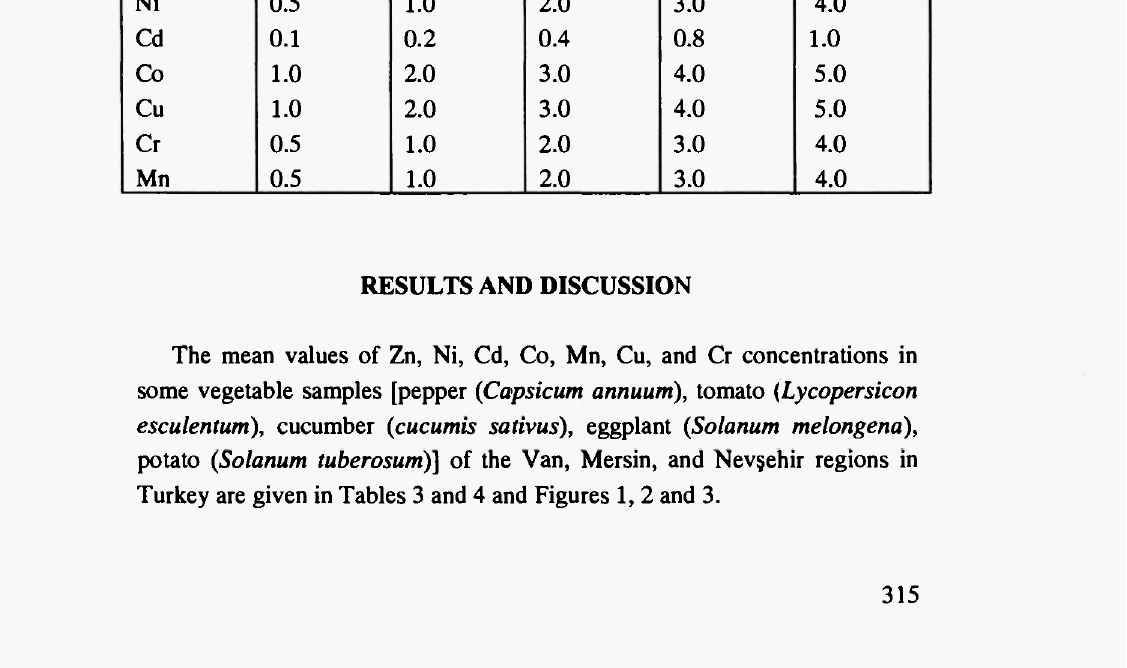
Concentrations of standard mixture solutions for calibration figures